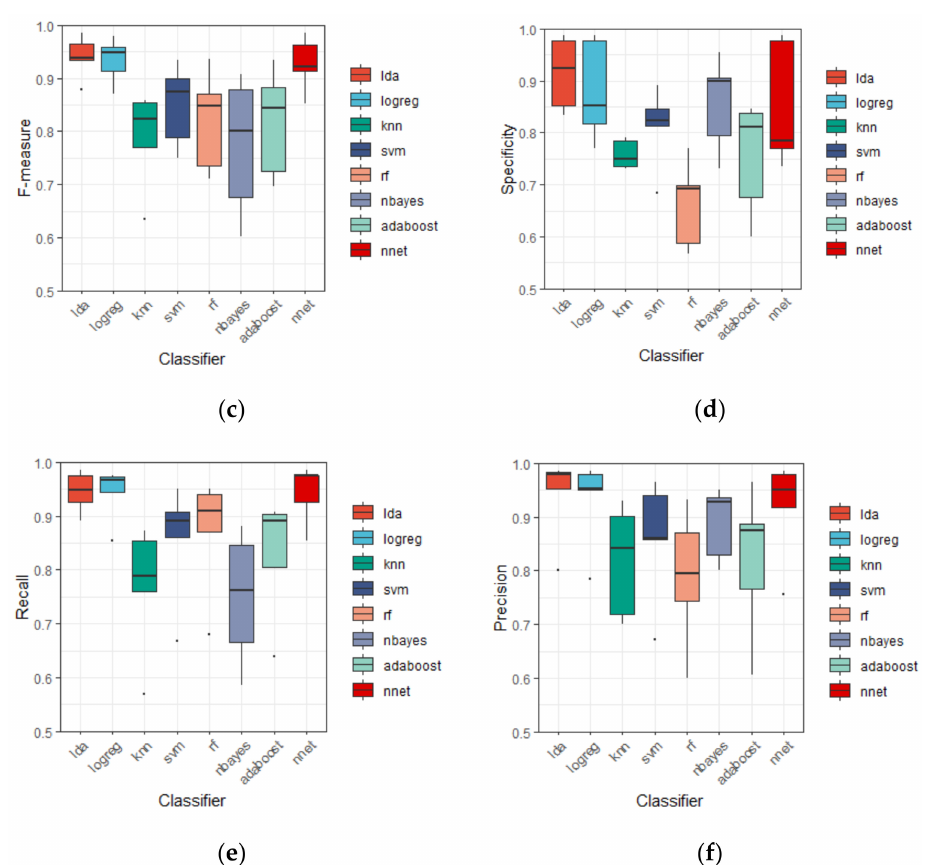
Figure 3. Boxplot of discriminant results by di ff erent classifiers using five-fold CV based on LA8 wavelet filter in terms of: ( a ) Accuracy; ( b ) AUC; ( c ) F-measure; ( d ) Specificity; ( e ) Recall; ( f ) Precision. Note: Each boxplot is constructed of the box and the whiskers. The box is drawn from Q 1 (25th percentile) to Q 3 (75th percentile) with a horizontal line drawn in the middle to denote the median. The